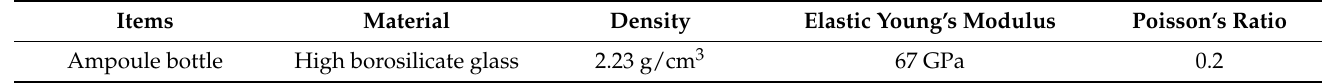
Figure 2. Mechanical model of an ampoule bottle with a V-shaped notch and semi-elliptical crack. ( a ) Schematic of loads and constraints. ( b ) Schematic of crack cross-section. Table 1. The material and physical properties of the ampoule bottle. Items Ampoule